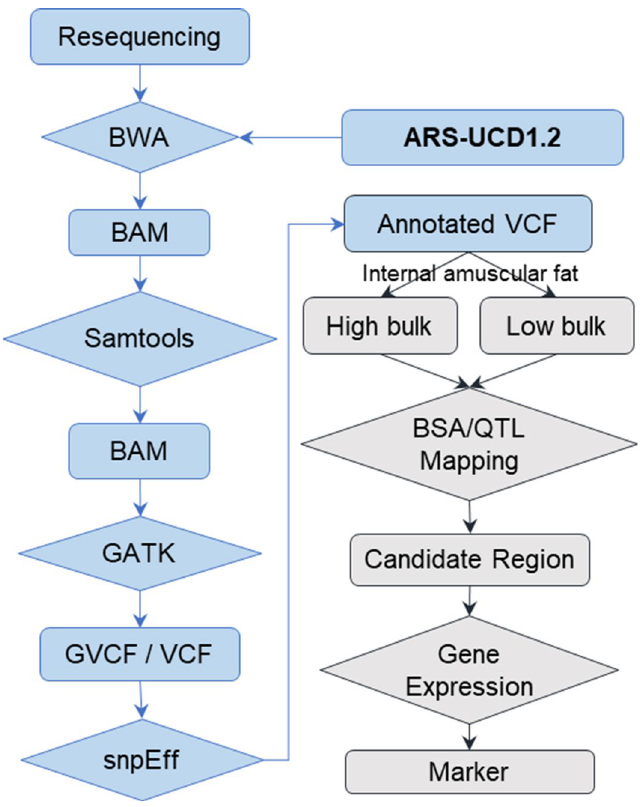
Figure 2. Workflow of variants calling (blue boxes) and QTL mapping (grey